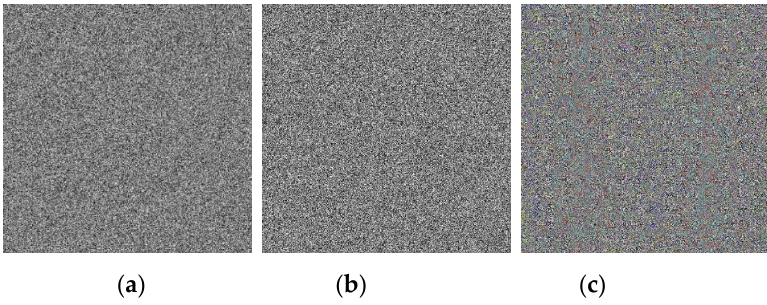
Figure 11. Cipher images: ( a ) 8BPP Lena; ( b ) 16BPP Lena; ( c ) 24BPP Baboon.